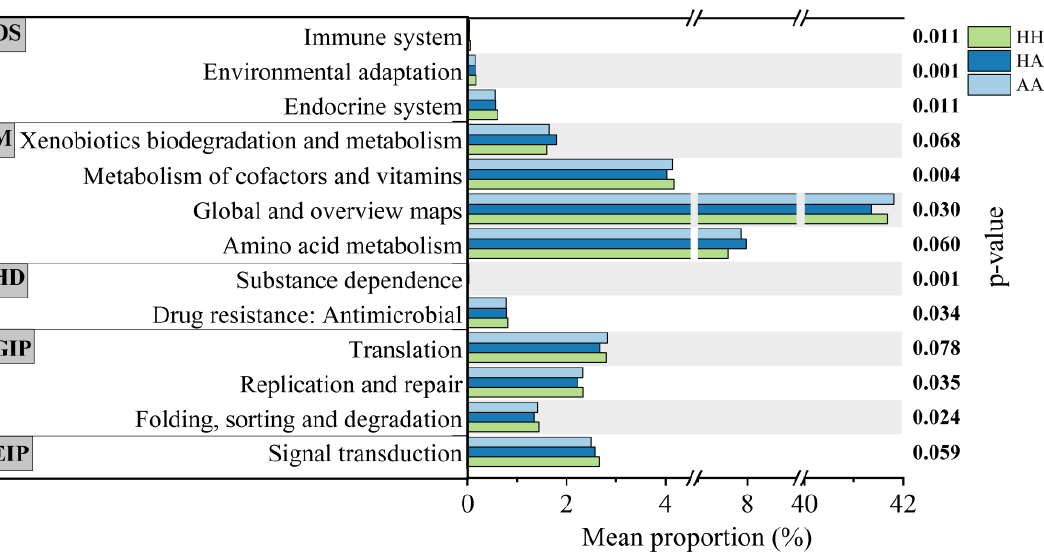
Figure 5. Predicted functional categories in KEGG pathways (level 2) using PICRUSt2. These differences among HH, HA, and AA groups were analyzed using the Kruskal Wallis H test. OS: Organismal Systems, M: Metabolism, HD: Human Diseases, GIP: Genetic Information Processing, and EIP: Environmental Information Processing.